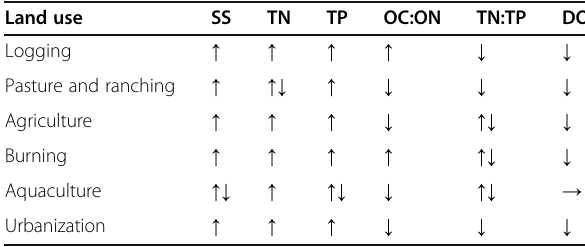
Table 2 A summary of the common effects of tropical land- use change on the downstream riverine and estuarine water properties. The arrows indicate that the water properties would increase ( ↑ ), decrease ( ↓ ), or not change ( → ). See the list of abbreviations for water